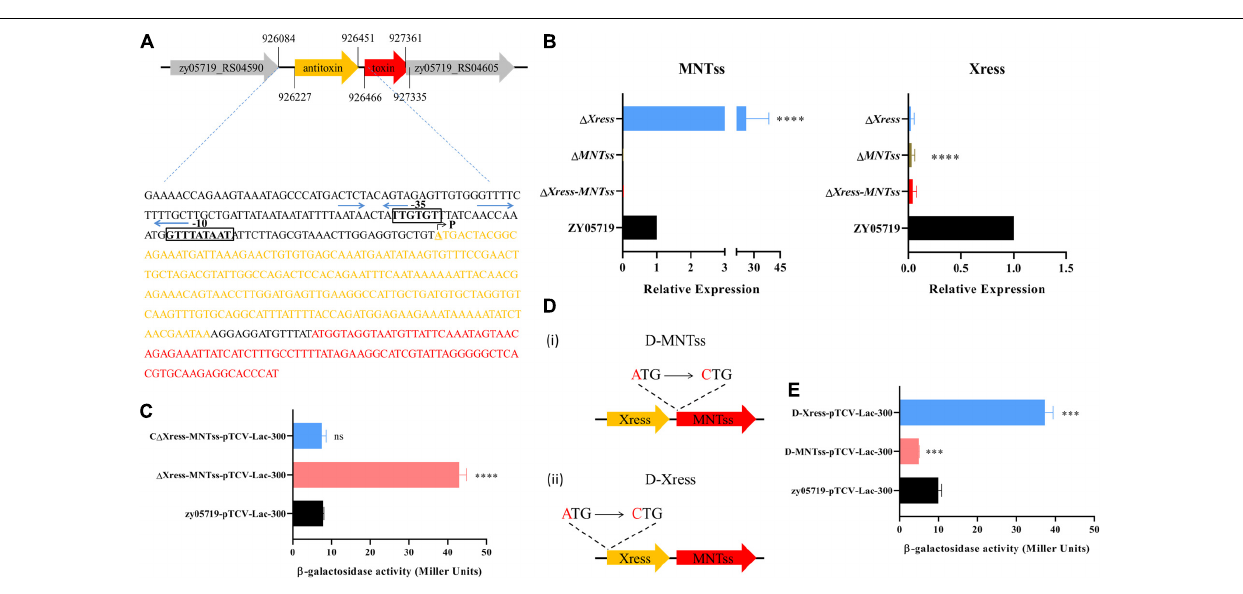
FIGURE 2 | Evaluation of relative expression and promoter activity in vivo . (A) Predicted Xress-MNTss promoter. Gray areas comprise the -35 box and -10 box regions, blue arrows represent the predicted palindrome sequences. P indicates the transcriptional start site (TSS). (B) Expression levels of MNTss and Xress in ZY05719, (cid:49) Xress-MNTss , (cid:49) MNTss , and (cid:49) Xress strains as measured by qRT-PCR. The relative expression levels represented the mean ± SD of three biological repeats. (C) The pTCV- lac reporter plasmid (pTCV- lac -300), containing the Xress-MNTss promoter sequence, was transferred to (cid:49) Xress-MNTss ,C (cid:49) Xress-MNTss and ZY05719 to determine β -galactosidase activity. (D) (i) Toxin point mutant D-MNTss was constructed by mutating the start codon ATG of MNTss to CTG; (ii) antitoxin point mutant D-Xress was constructed by mutating the start codon ATG of Xress to CTG. (E) Promoter assay using pTCV- lac -300 integrated in the D-MNTss and D-Xress host. The data are shown as the means and standard deviations of the results from three independent experiments performed in triplicate. Unpaired two-tailed Student’s t -test: ns, P > 0.05; ∗∗∗ P < 0.001; ∗∗∗∗ P <